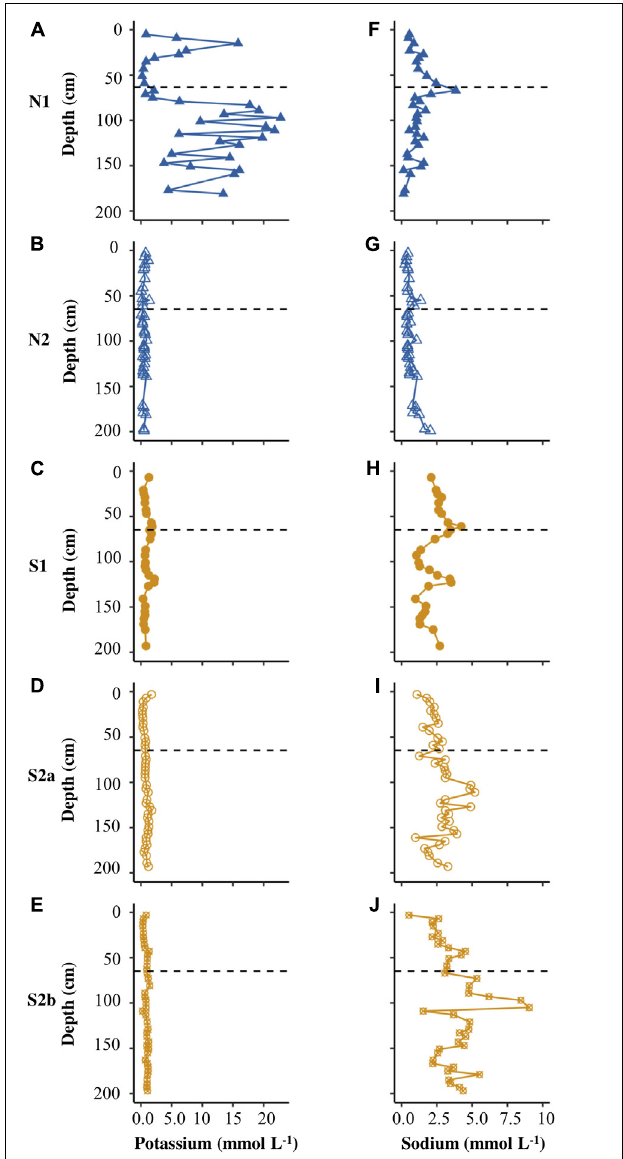
FIGURE 5 | Depth profiles of potassium (A–E) and sodium (F–J) for N1, N2, S1, S2a, and S2b. The horizontal dashed line on each plot represents the base of the active layer in